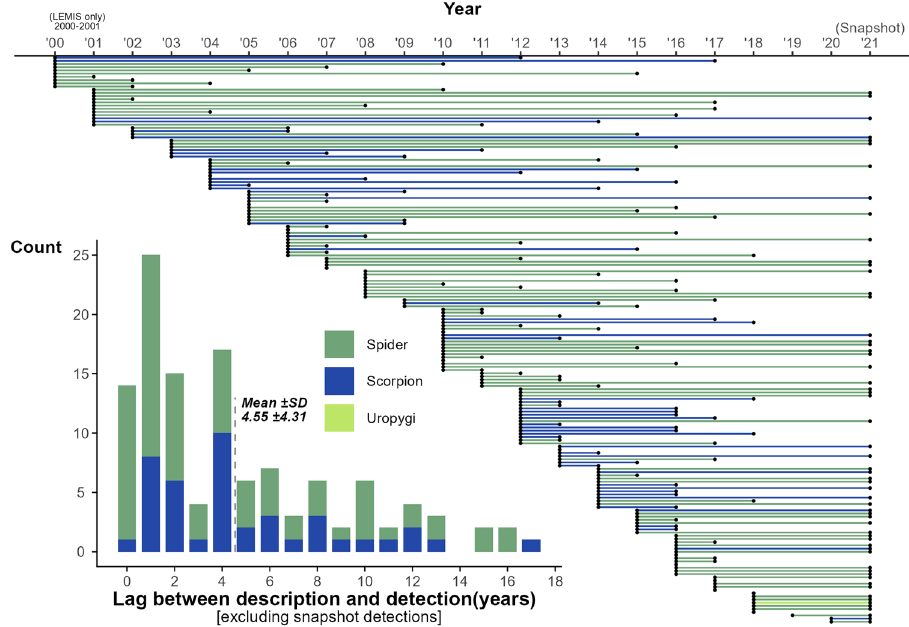
Fig. 5 Years of detection in the trade of species described post-1999 (via LEMIS or online). Inserted histogram shows the count of the year lags for those species detection could be connected to an exact year (i.e., not detected in the 2021 snapshot